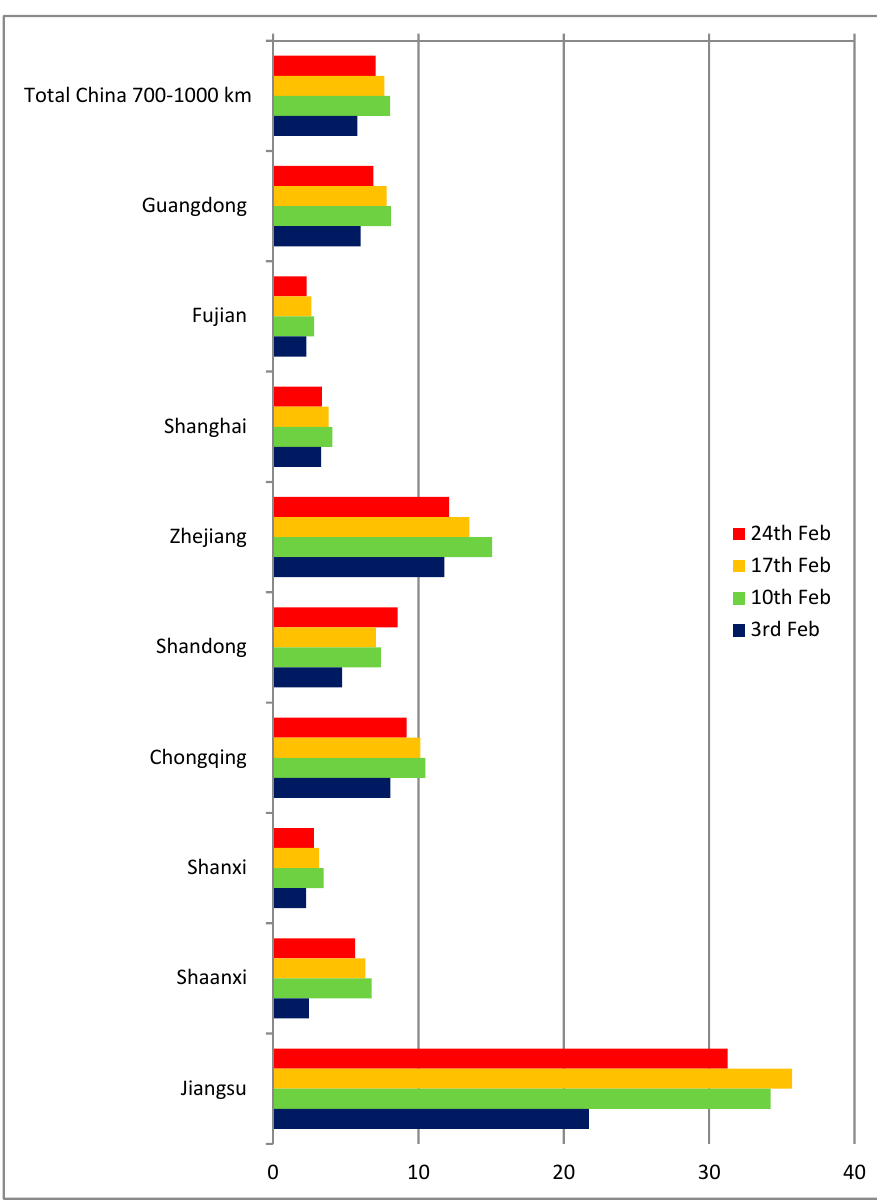
Figure 3. Estimated ratio of infected passengers (cases per 1000 passengers), China (700–1000 km from Wuhan). On the other hand, the picture is more homogeneous for Chinese provinces and territories over 1000 km from Wuhan (Figure 4). For such distances, air travel is practically the only option for passengers and the q indicator has a range of between 2 and 6 cases per thousand passengers. The two outliers are Tibet (with a single case in the period, but also a very low number of estimated passengers) and Heilongjiang, where the number of cases was proportionally higher already on February 3, possibly as a result of the province having entered the local transmission phase